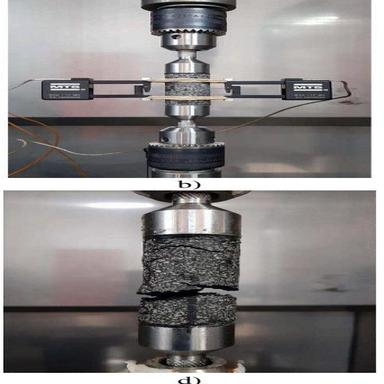
FAM samples: a) after gluing the metal plates and ready to be tested in the servo-hydraulic machine, b) installed in the machine and ready to be tested, c) and d) after tested to identify the cracks developed.